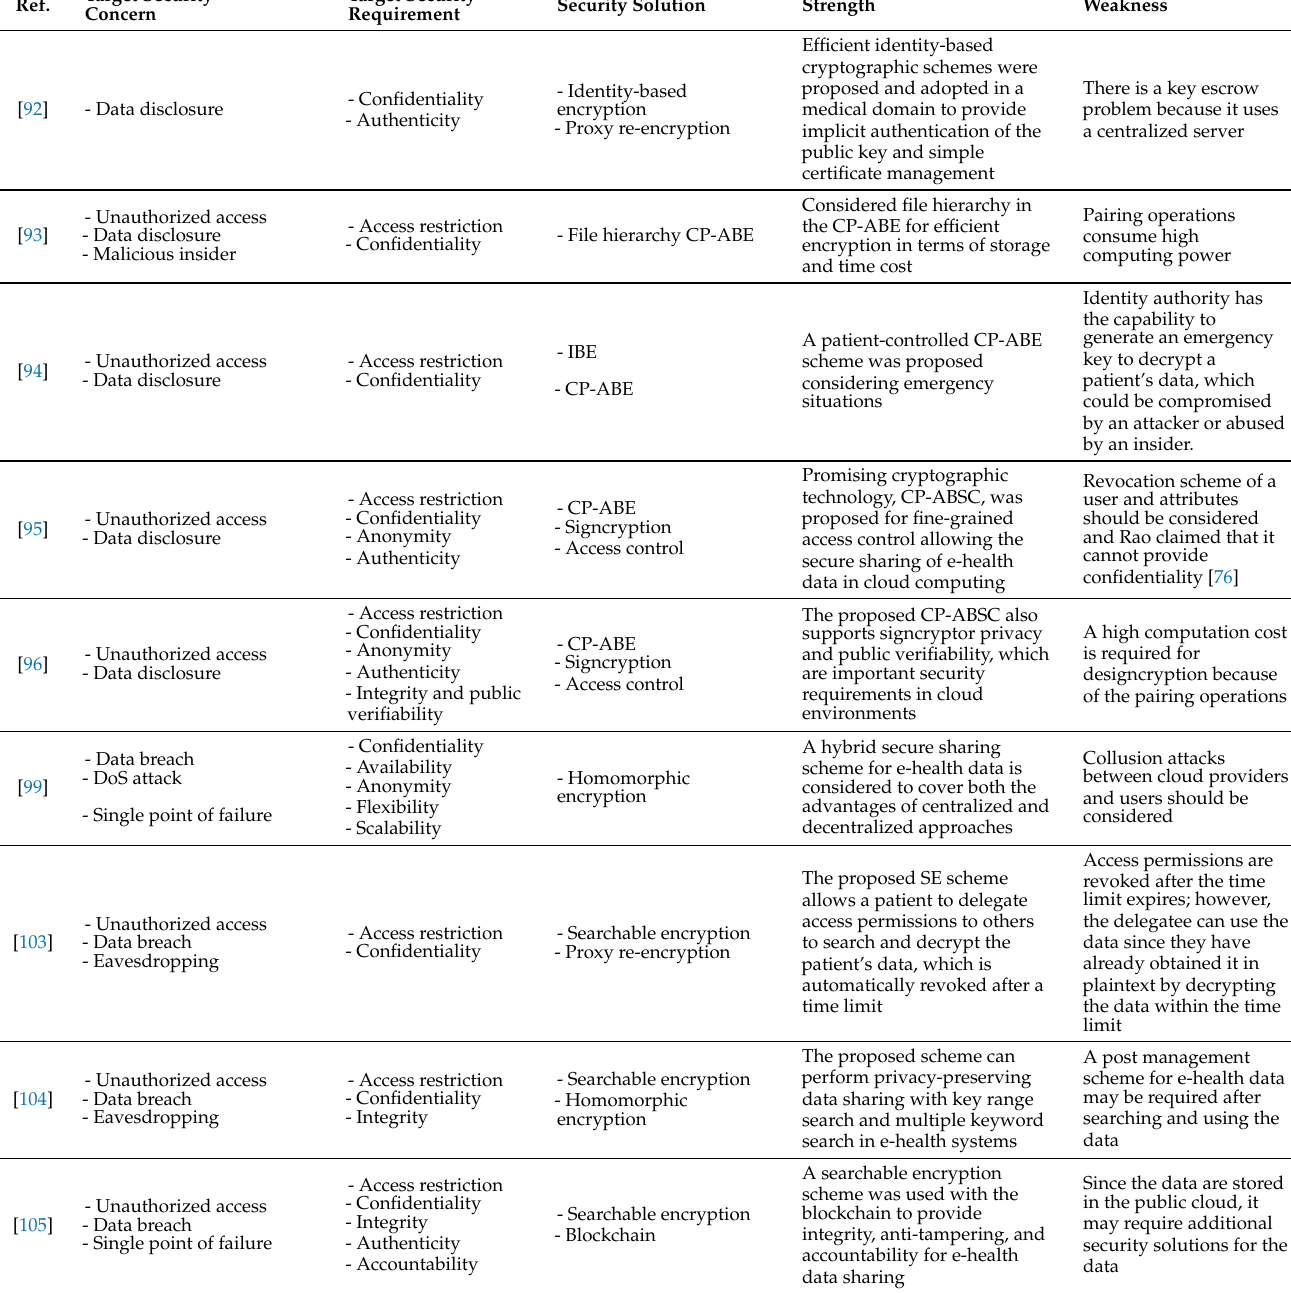
Table 6. Summary for the security and privacy studies on edge, fog, and cloud computing.